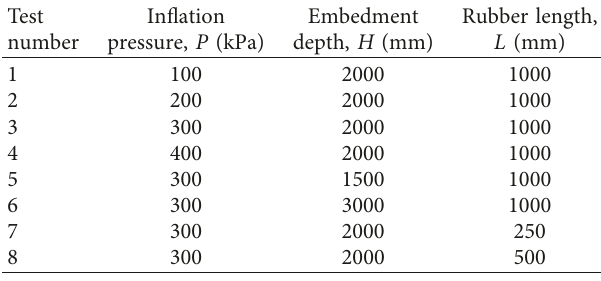
Figure 6: The relationship between peak and residual pullout force with respect to inflation pressures.